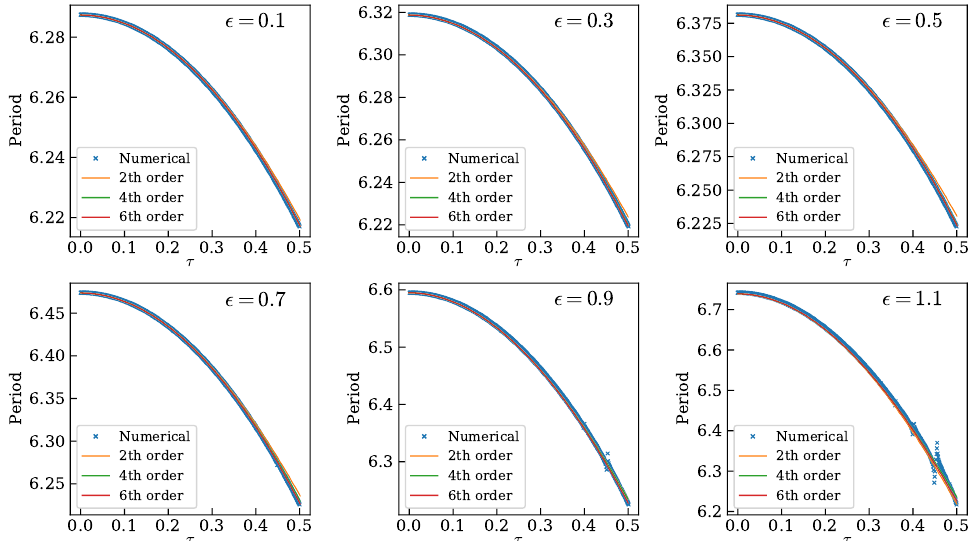
Figure 9. Comparison between the numerical and analytical results (using perturbation theory) for the period of the limit cycle. Each figure is an analogue of Figure 8 for the value of (cid:101) indicated in the top right